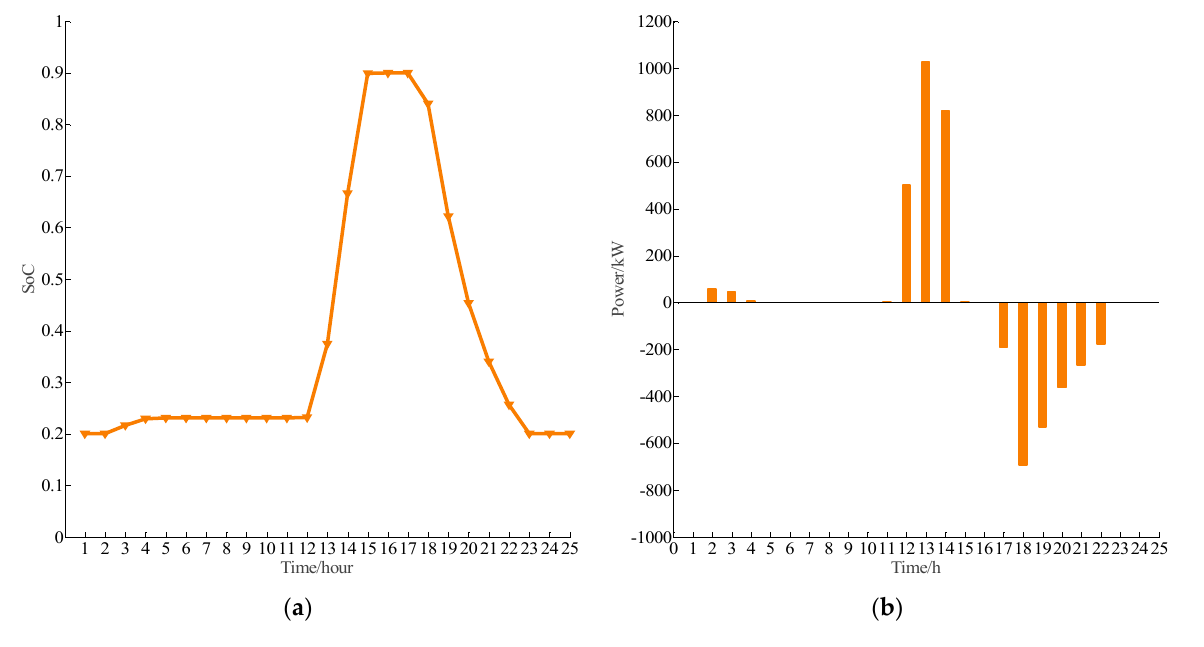
Figure 6. State of SESS and charging and discharging power: ( a ) state of charge; ( b ) charging and discharging power.